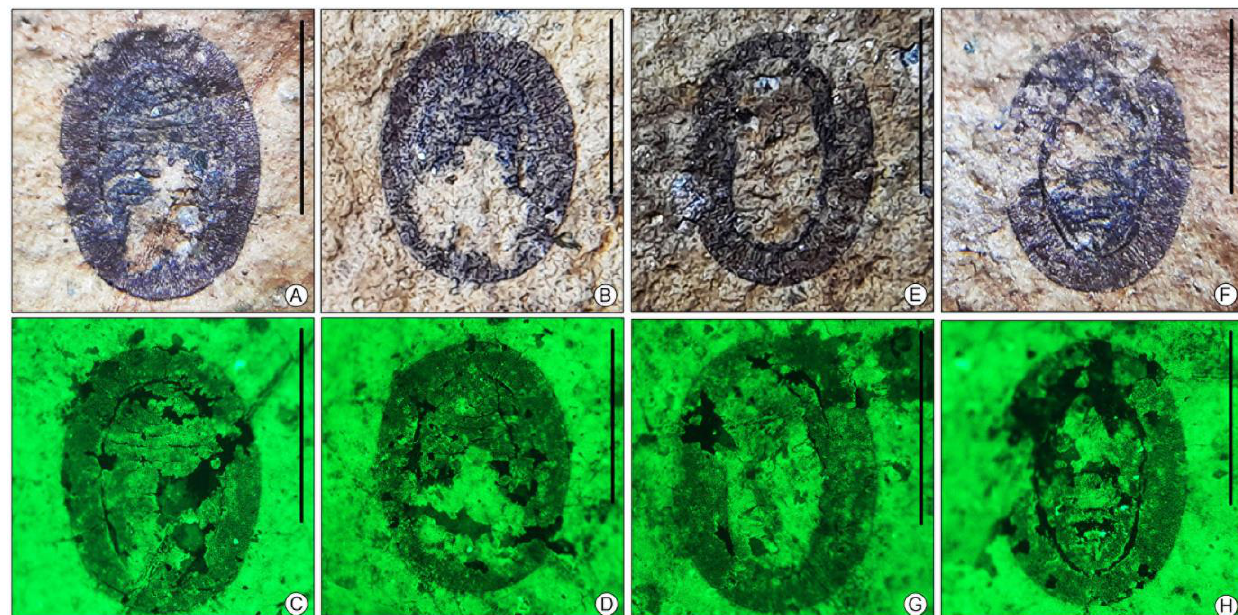
Figure 3. Praealeurolobus indicus gen. et sp. nov. Close-up view of specimen SKBUH/PPL/JH/I2. ( A , B ) and ( E , F ) stereo-zoom microscopic images of young puparia of whitefly. ( C , D ) and ( G , H ) fluorescence microscopy images of young puparia of whitefly. Scale bar = 1 mm.